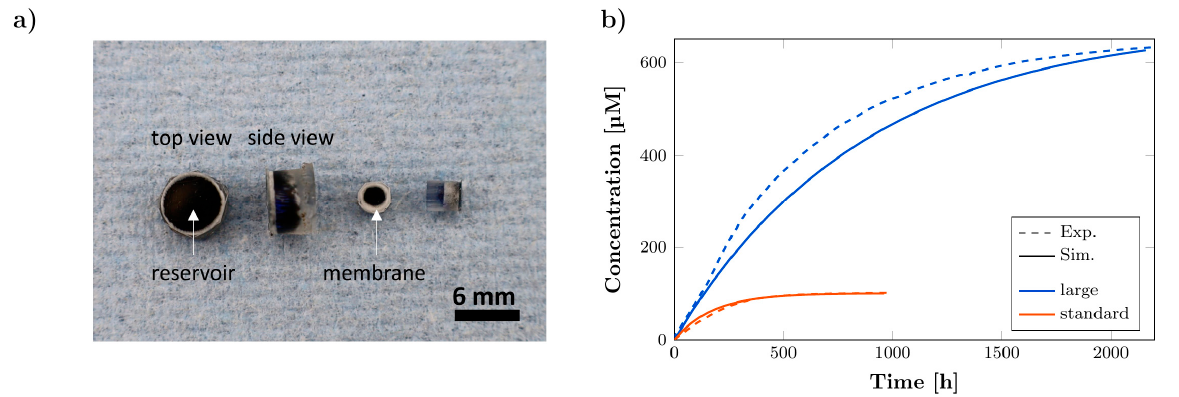
Figure 7. Long-term release kinetics. ( a ) Photograph of top and side view of large and standard-sized rDDS loaded with methylene blue (MB) solution. ( b ) Long-term release from large and standard-sized rDDS with 4.5% membrane porosity and initial concentration inside the reservoir of 100 mM with experimental results (Exp.) compared to simulation data (Sim.). Experimental concentration curves are averages ( n = 2 for large and n = 3 for standard-sized rDDS).